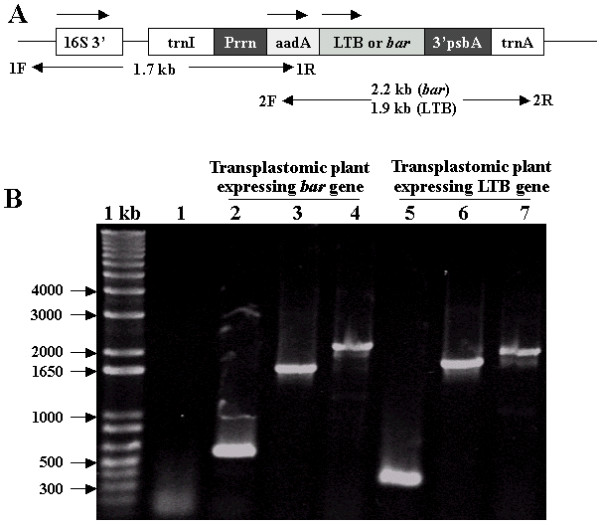
Schematic diagram of the chloroplast genome transformed with the bar or LTB gene and PCR analysis of wild-type and chloroplast transformants. (A) Map of the chloroplast targeting region in transplastomic plants. Arrows indicate the direction of transcription. Primer 1F is located in the native chloroplast DNA; 1R, aadA; 2F, aadA; 2R, trnA. (B) The PCR products of transplastomic plants. Lane 1, wild-type plant with primers Bar-F/Bar-R; lane 2, primers Bar-F/Bar-R produce a 550-bp fragment; lanes 3 and 6, primers 1-F/1-R produce a 1700-bp fragment; lane 4, primers 2-F/2-R produce a 2200-bp fragment containing the bar gene; lane 5, primers LTB-F/LTB-R produce a 380-bp fragment; lane 7, primers 2-F/2-R produce a 1900-bp fragment containing the LTB gene. 1 kb, DNA molecular weight ladder.